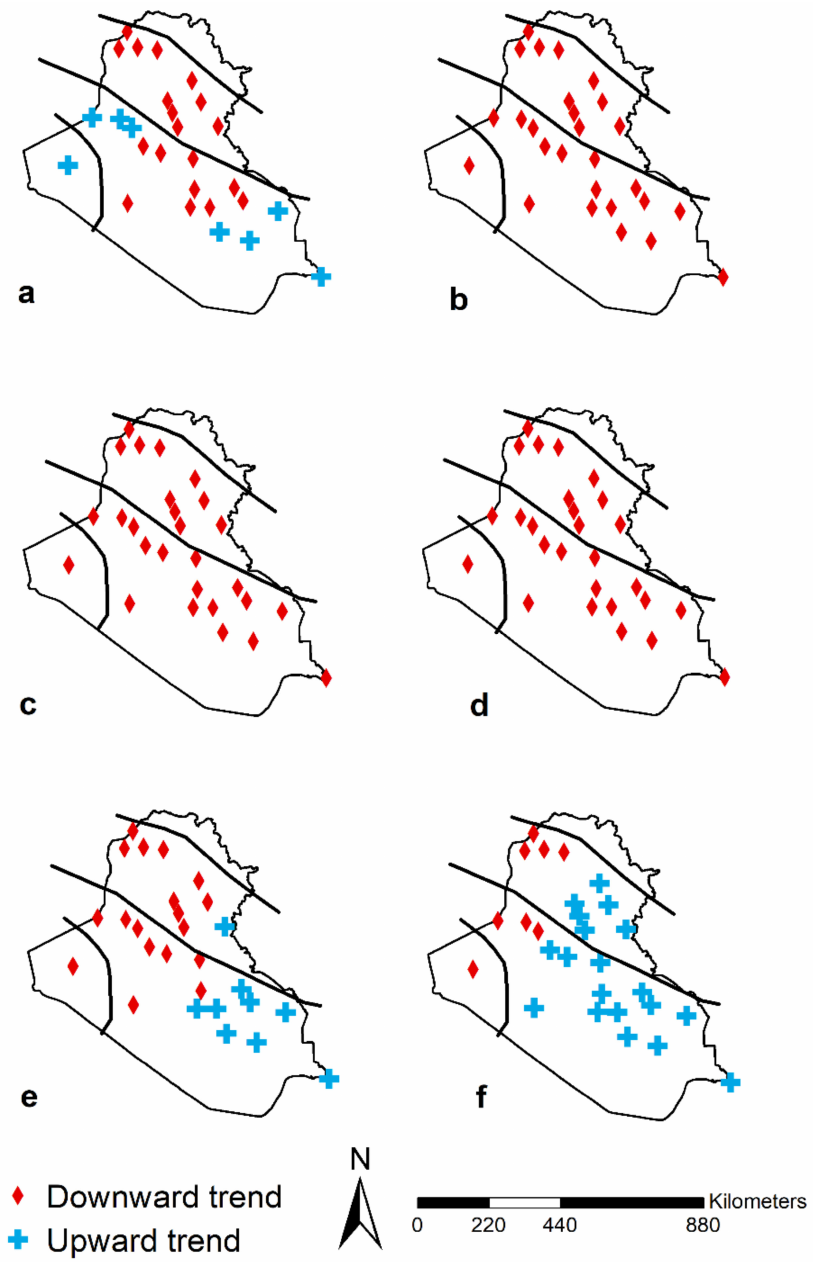
Figure 10. Spatial variation in upward and downward annual rainfall trend using Mann–Kendall test for ( a ) observed precipitation, ( b ) bcc-csm-1-1 model, ( c ) bcc-csm-1-1-m model, ( d ) CCM4 model, ( e ) MIROC5 model and ( f ) MRI-CGCM3